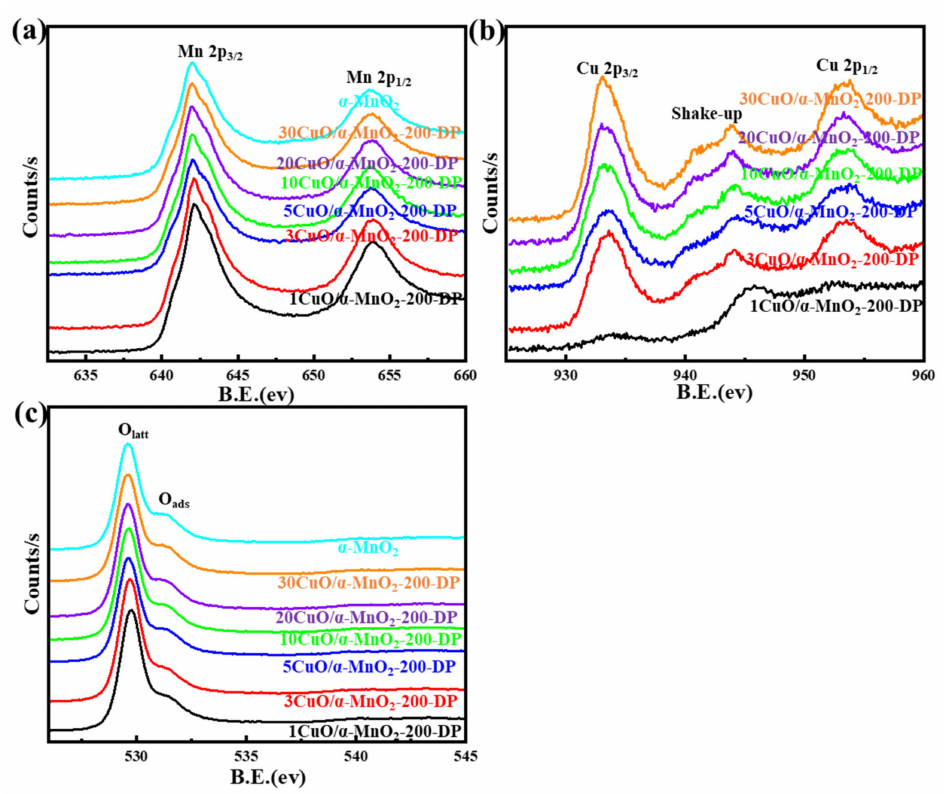
Figure 6. XPS spectra of Mn 2p ( a ), Cu 2p ( b ) and O 1s ( c ) for x CuO/ α -MnO 2 -200-DP catalysts with different CuO loading.